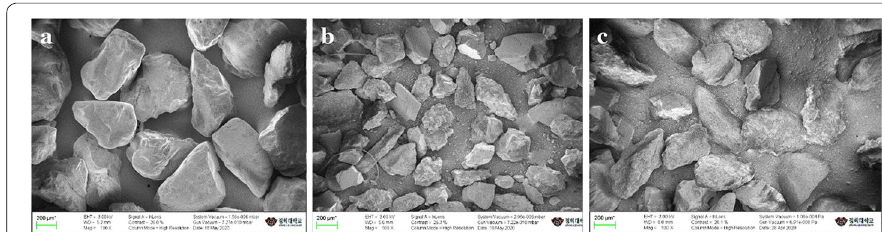
Fig. 6 The SEM images for test materials with size of 0.25–0.425 mm: a the Jumunjin silica Sand; b the Dissa Calcareous sand; c the Matmata calcareous sand